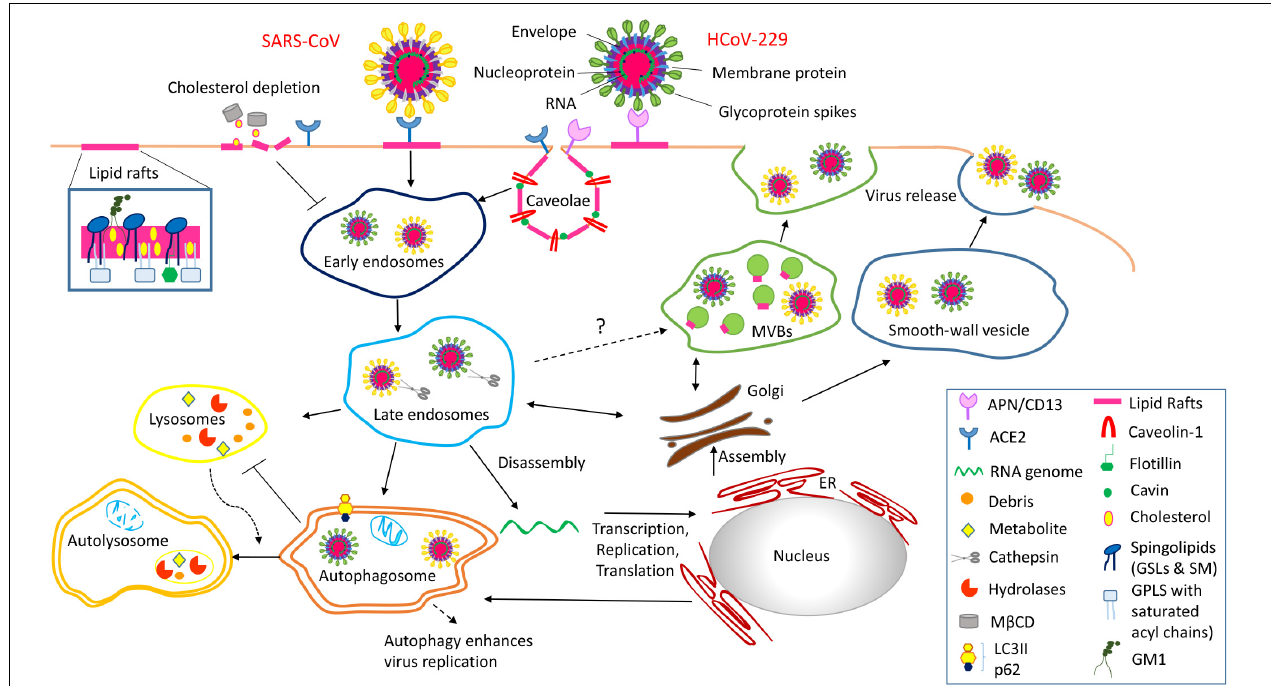
FIGURE 1 | Schematic representation of the role of lipid rafts in Coronavirus infection of the host cells is a multistep endocytic process characterized by a series of complex events tightly regulated in space and time. Step 1 Entry process of coronavirus into the host cells is initiated by the binding of the spike glycoprotein with the specific receptor (ACE2, APN/CD13) located into lipid rafts/caveolae. This interaction causes conformational changes of the viral particle, which trigger specific signaling events necessary for the viral entry mechanism. Step 2 Lipid rafts/caveolae-mediated endocytosis is followed by intracellular trafficking of virus particles in transport vesicles (early and late endosomes). The low pH in late endosomes induces a conformational change in coronavirus that mediates fusion of the viral envelope with the endosomal membrane. Step 3 Viral genomes are translated in two polyproteins, pp1a and pp1ab, which encode the non-structural viral proteins that form the replication transcription complex. This complex produces genomic RNA as well as multiple subgenomic mRNAs encoding structural proteins. Translation of mRNA encoding for the nucleocapsid proteins occurs in the cytoplasm where the newly synthesized proteins interact with new genomes to form ribonucleoprotein particles. In contrast, matrix, envelope and spike proteins translation occurs into the ER. Coronavirus uses also the autophagy machinery for replication and has evolved strategies to avoid autophagy-induced lysosomal degradation. Step 4 After assembly the progeny viral particles, virus-containing vesicles (smooth-wall vesicles) are budded and released into the extracellular environment through fusion with the plasma membrane (exocytosis). Alternatively, we speculate that coronavirus might utilize multivescicular bodies (MVBs) and take advantage of the exosomal pathway for